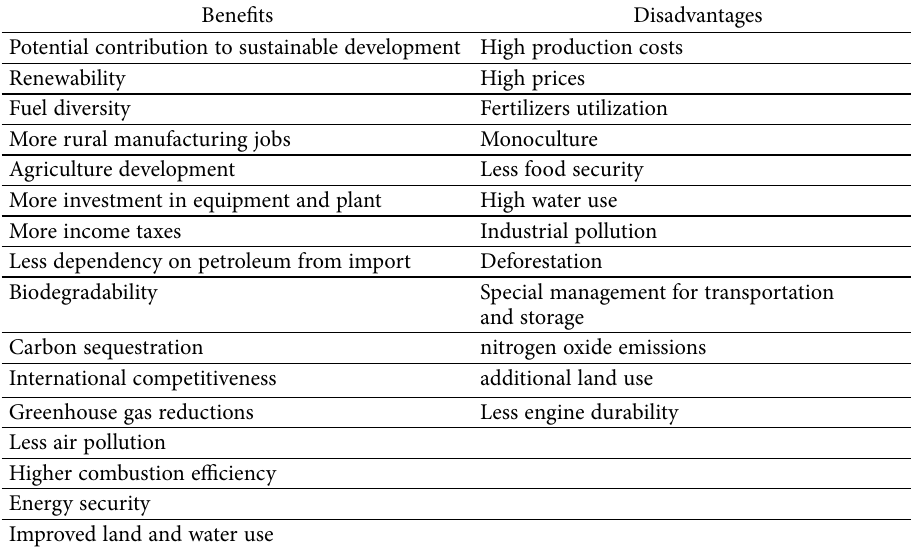
Table 1. The main benefits and disadvantages of biofuels